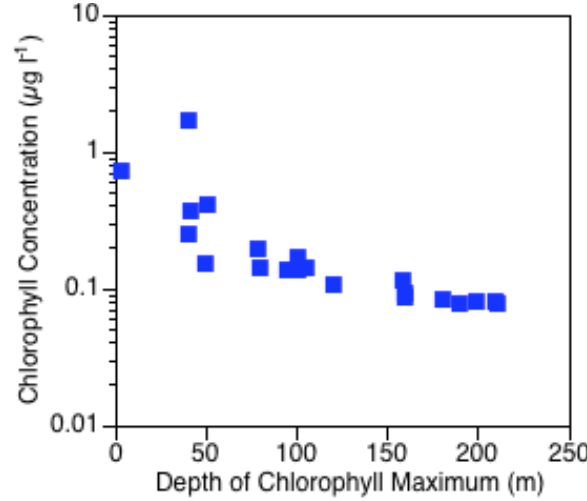
Fig. 3. Relationship between average chlorophyll concentration and Fig. 3 Relationship between average chlorophyll concentration and the depth of the depth of the chlorophyll maximum layer among the stations the chlorophyll maximum layer among the stations sampled.